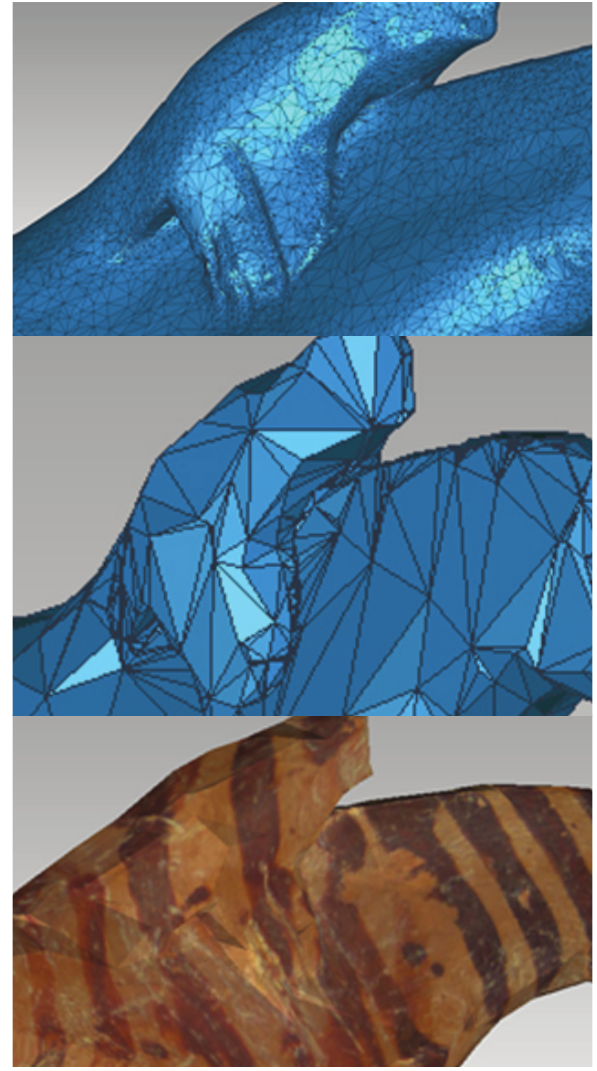
Figure 14. Model of a fi gurine of a rider on a horse before (102.000 triangles: above) and after decimation (~5.000 triangles: center and below, texturized)